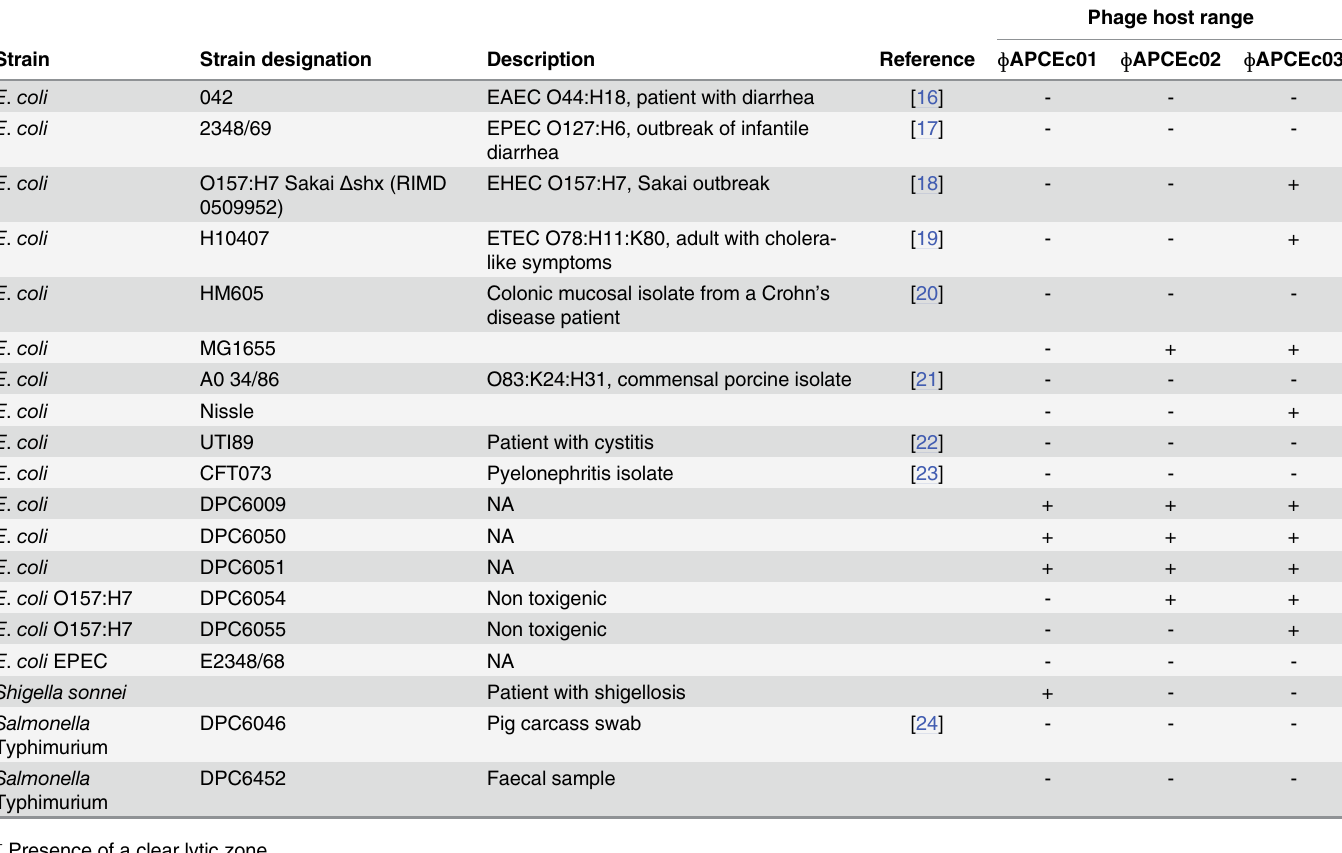
Table 1. Strains used in this study and host range of phages ɸ APCEc01, ɸ APCEc02 and ɸ